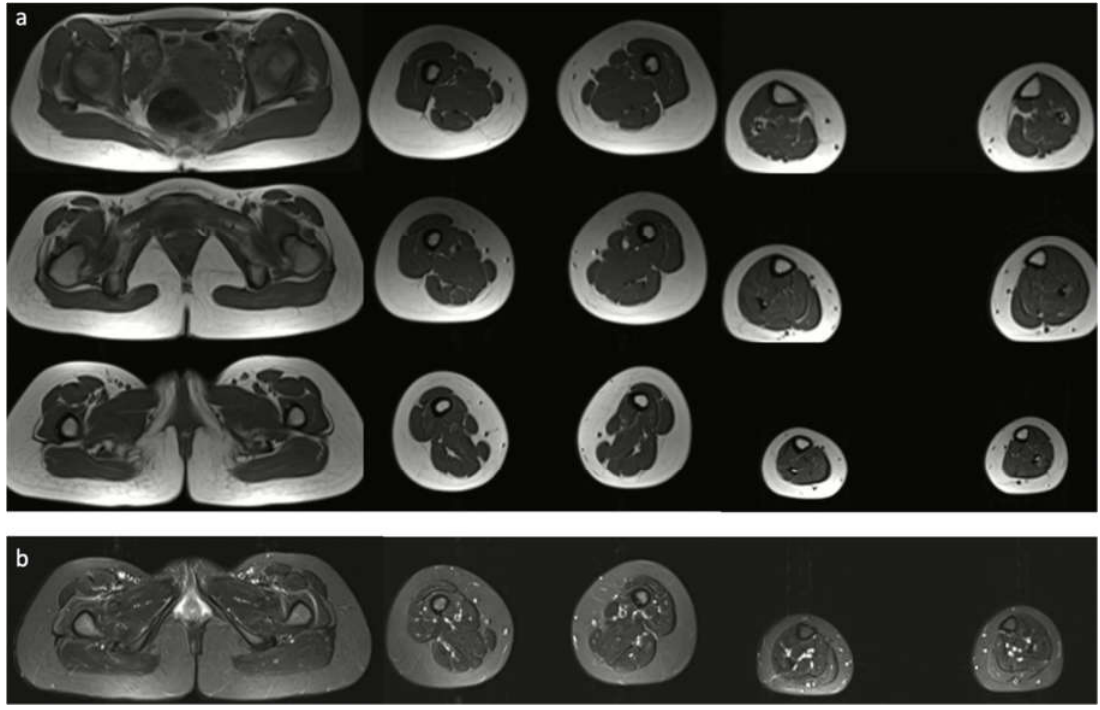
Figure 3. T1-weighted (a) and T2-STIR (b) muscle MR-images of the lower limbs. Reducing the volume of the anterior compartment of the thigh and lower leg muscles is noted. There is no moth- eaten appearance on T1-weighted images (a) . T2-STIR images (b) show no edematous changes of quadriceps and gastrocnemius muscles.